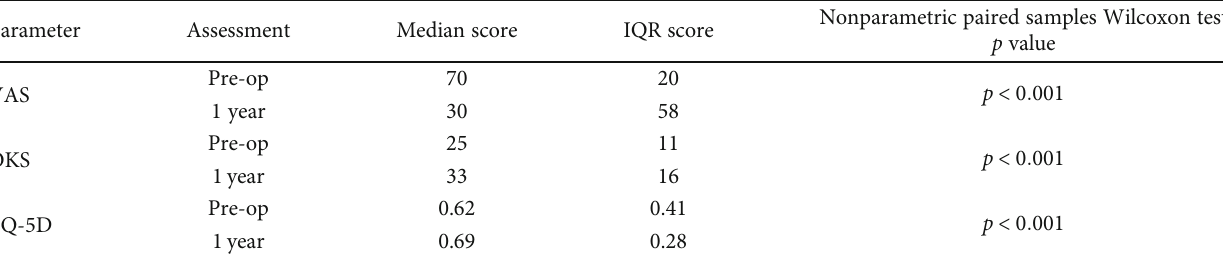
Table 3: Summary